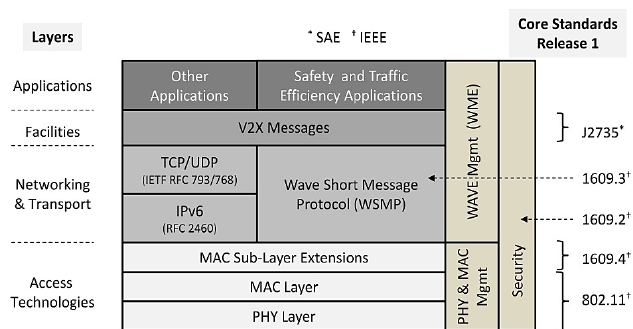
Fig. 5. Example of a WAVE system component, based on [53], [54].